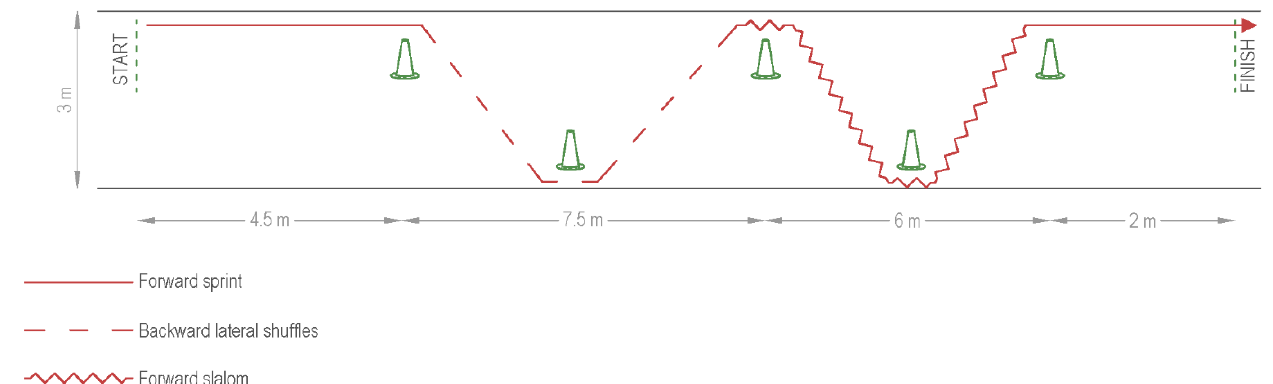
Figure 13. The trajectory of the New Preplanned agility test (NPP agility); adapted and edited from [39] .